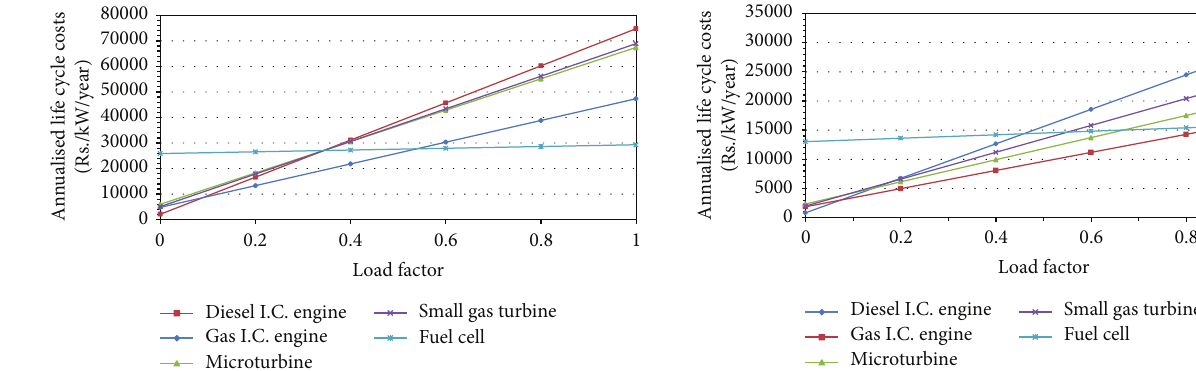
Figure 6: Comparison of annualised life cycle costs for different technological options when DG-CHP is considered (discount rate (𝑑) = 10 %) for the month of June 2011.